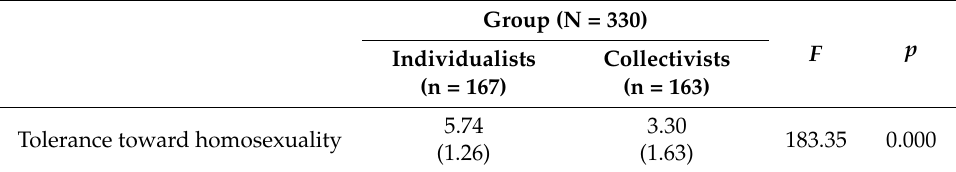
Table 1. ANOVA Results: Effect of Cultural Orientation on Tolerance toward